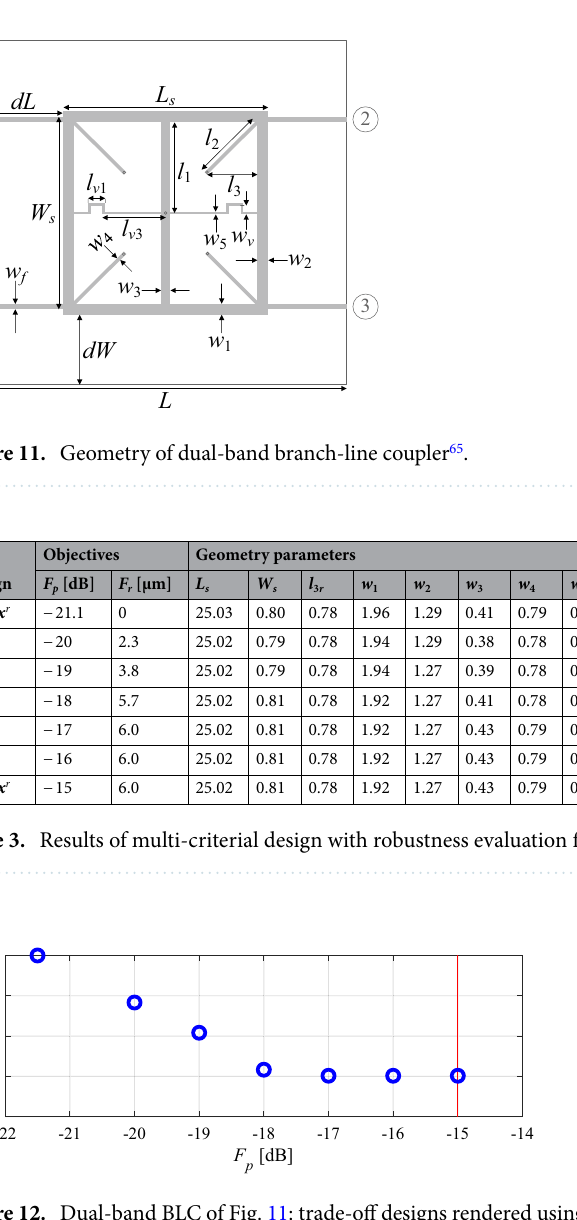
Figure 12. Dual-band BLC of Fig. 11: trade-off designs rendered using the introduced multi-criterial optimization framework. The maximal acceptable value of in-band | S 11 | and | S 41 | is marked using vertical